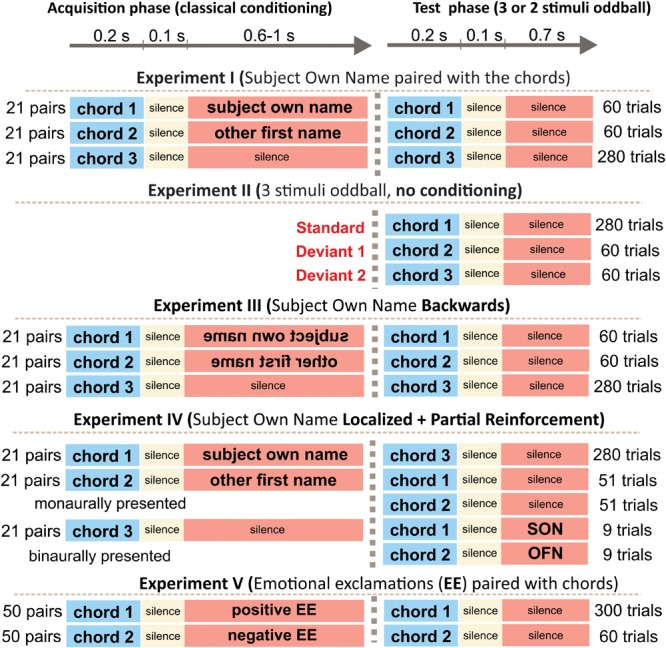
Experimental design.